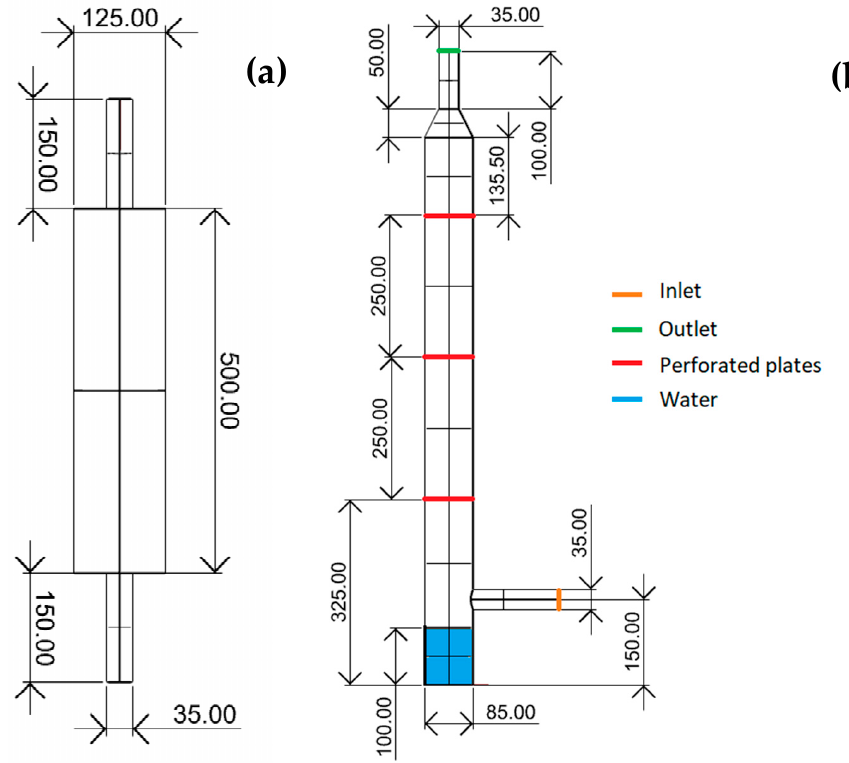
Figure 6. Geometry of ( a ) expansion chamber and ( b ) model-scale scrubber; dimensions in mm.